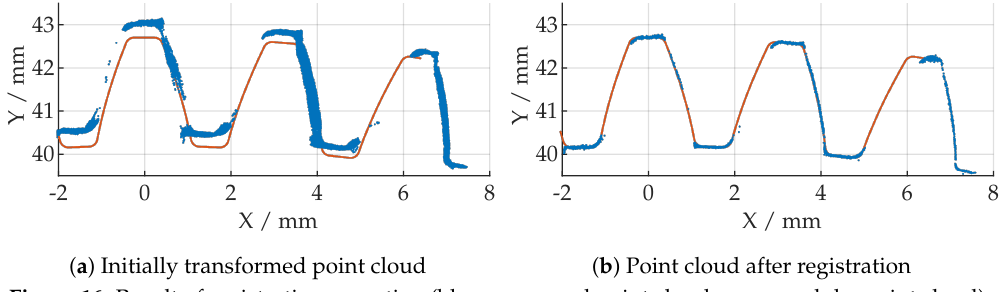
Figure 16. Result of registration operation (blue: measured point cloud, orange: alpha point